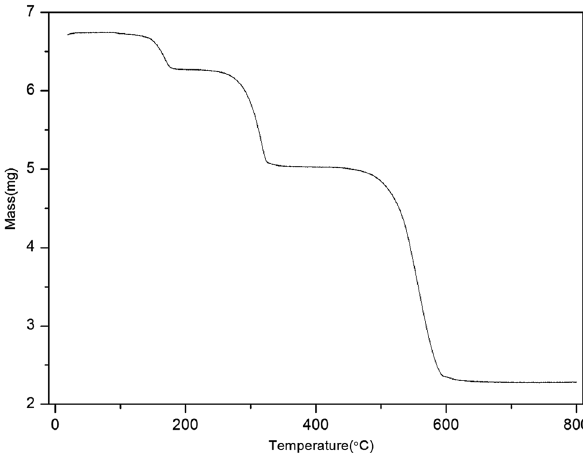
Figure 2: Thermogravimetric analysis of the Sm -